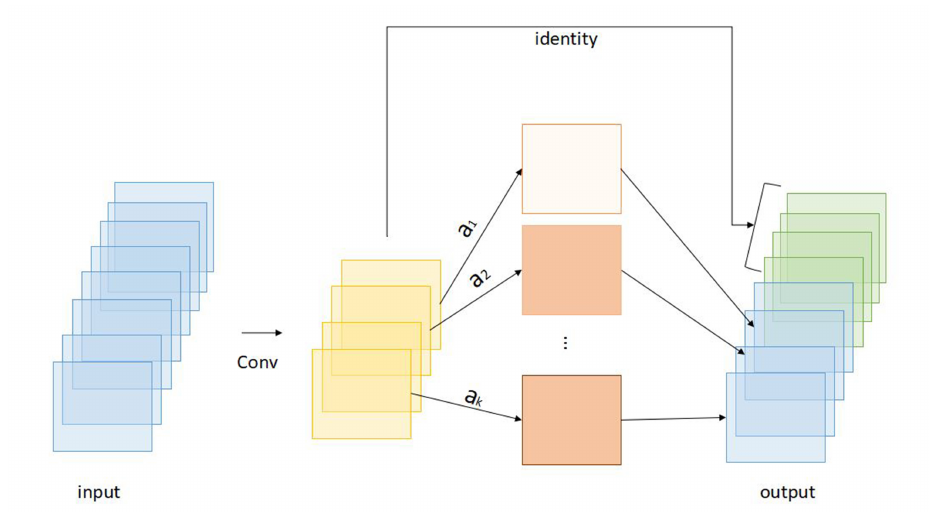
Figure 4. Ghost module structure. The letter “a” in the figure represents the depth-separable convolution operation.